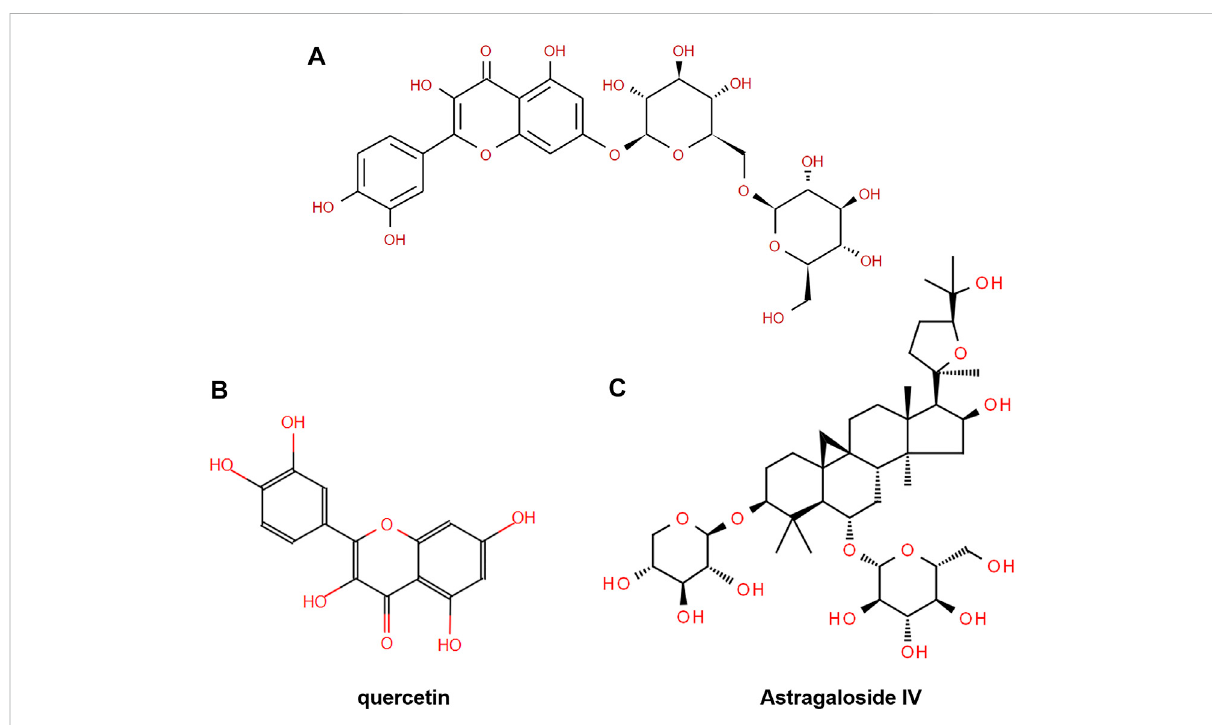
FIGURE 2 Chemical structure of (A) quercetin-7-O- β -D-glucopyranosyl (1 → 6)- β -D-glucopyranoside, (B) quercetin, and (C) astragaloside IV.